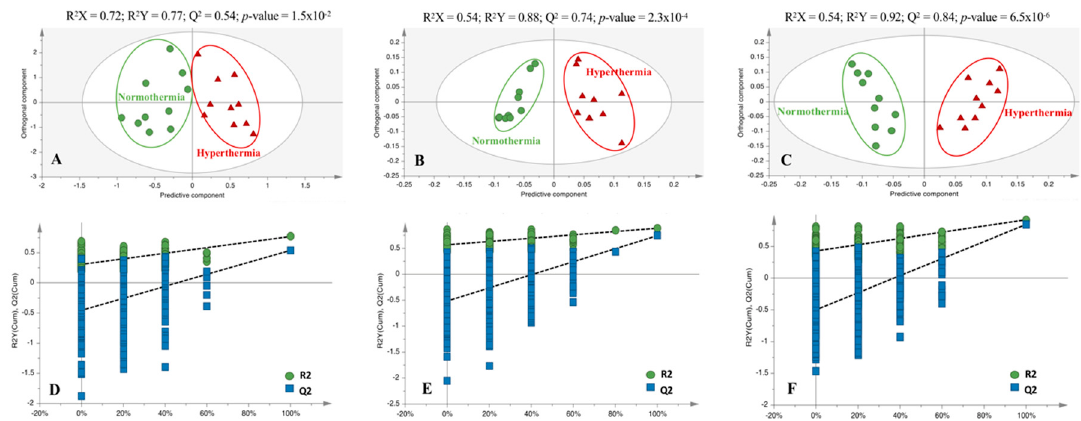
Figure 2. Orthogonal projections to latent structures discriminant analysis (OPLS-DA) score scatter plots obtained for the chromatograms corresponding to cells exposed to normothermic ( n = 10, ● ) and hyperthermic ( n = 10, ▲ ) conditions, after analysis of the ( A ) intracellular metabolome, ( B ) volatile organic compound (VOC) and ( C ) volatile carbonyl compound (VCC) in extracellular metabolome. ( D – F ) Statistical validation of the respective OPLS-DA models obtained by permutation tests (500 permutations).